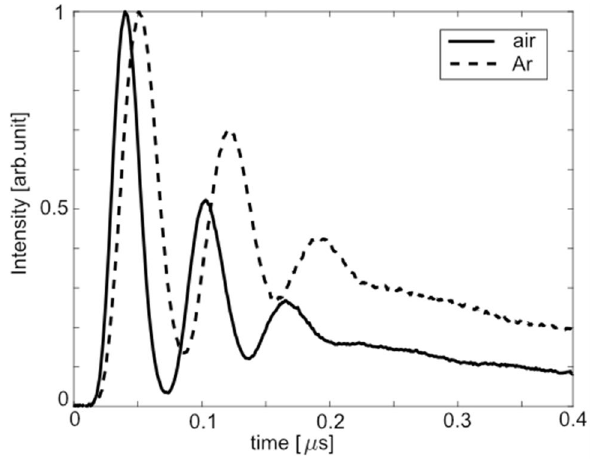
Figure 10. Normalized fs-LIGS signals of air and argon (Ar) recorded in a gas flow of respective gas at the laser 2 energy 500 µ J (30 TW/ cm